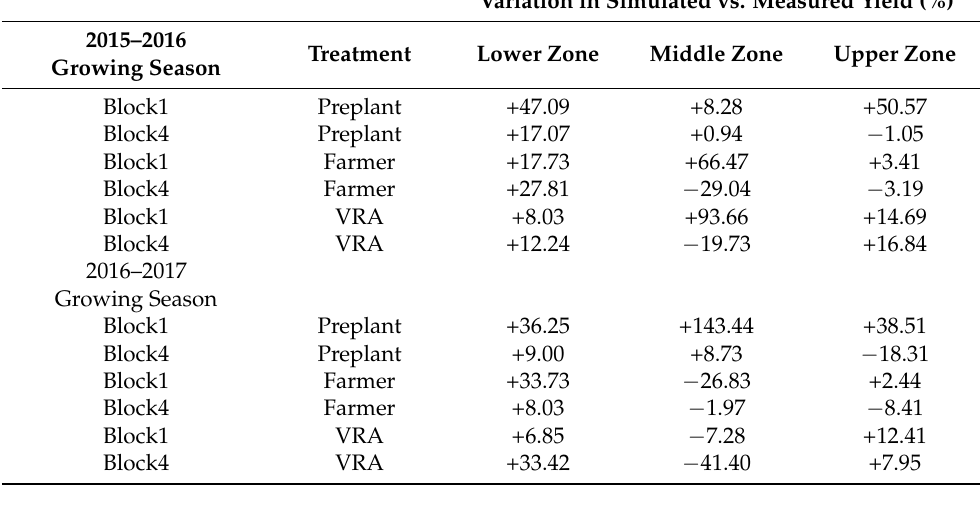
Figure 6. Observed (black line) and simulated (blue area) soil water content of 1 m profile.